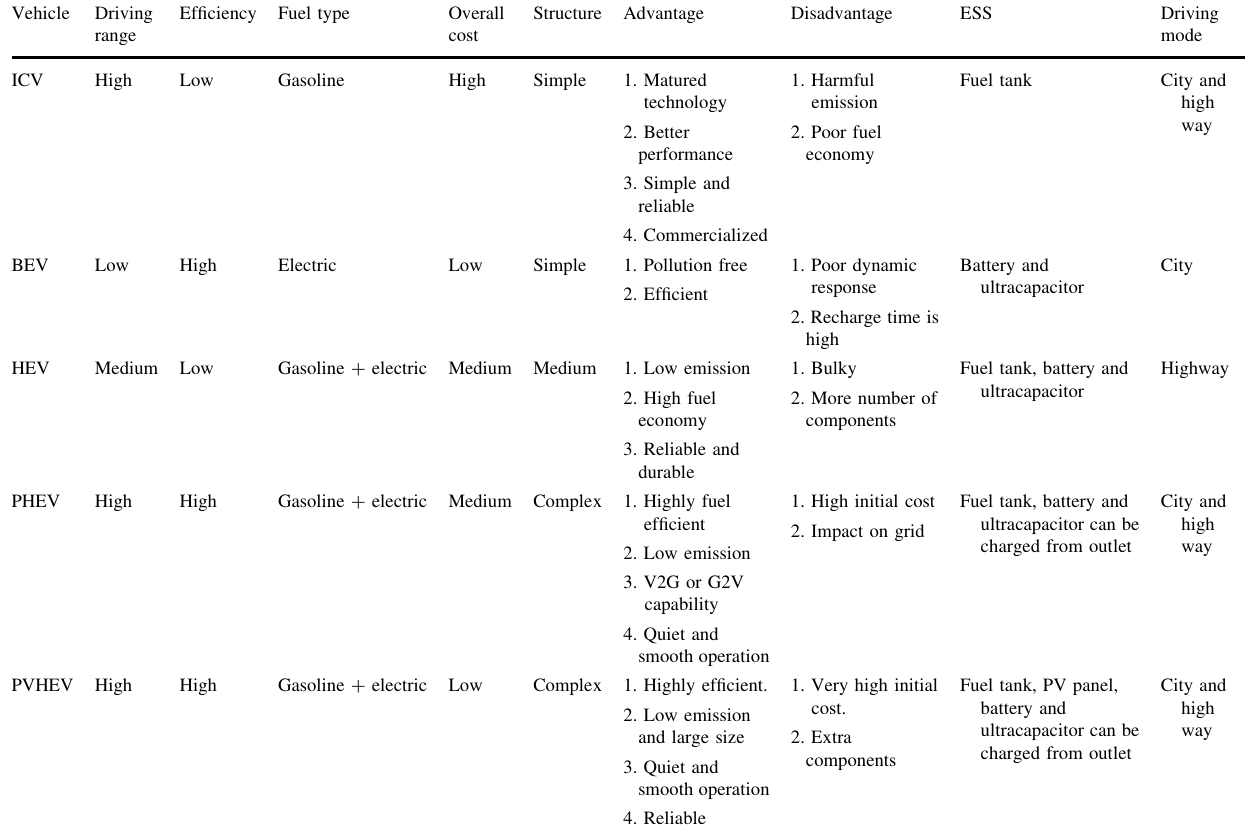
Table 9 Comparison of various existing hybrid vehicles